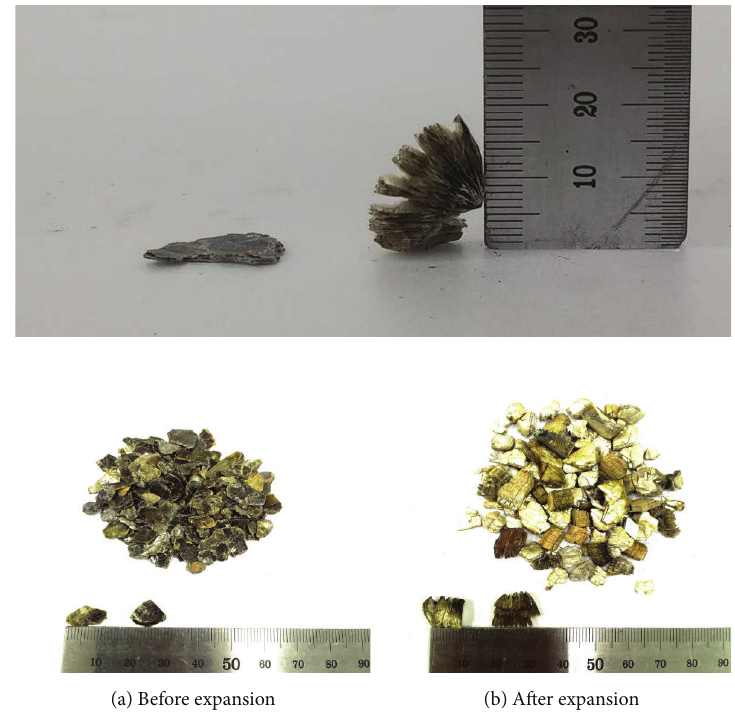
Figure 1: Thermal expansion of the vermiculite